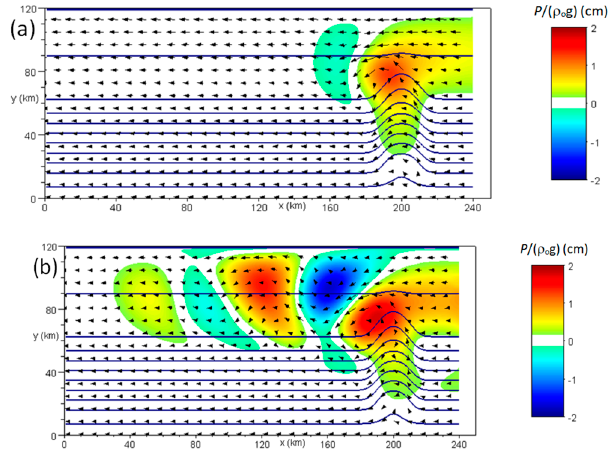
Figure 9. Same as Figure 6a, but for the canyon-upwelling scenario after: ( a ) 5 days; and ( b ) 15 days.